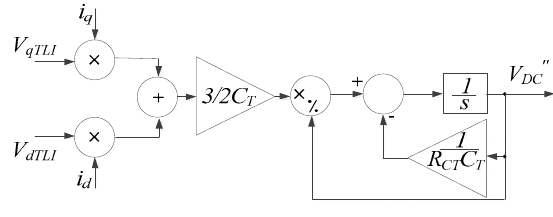
Figure 11. Block diagram of TLI model.